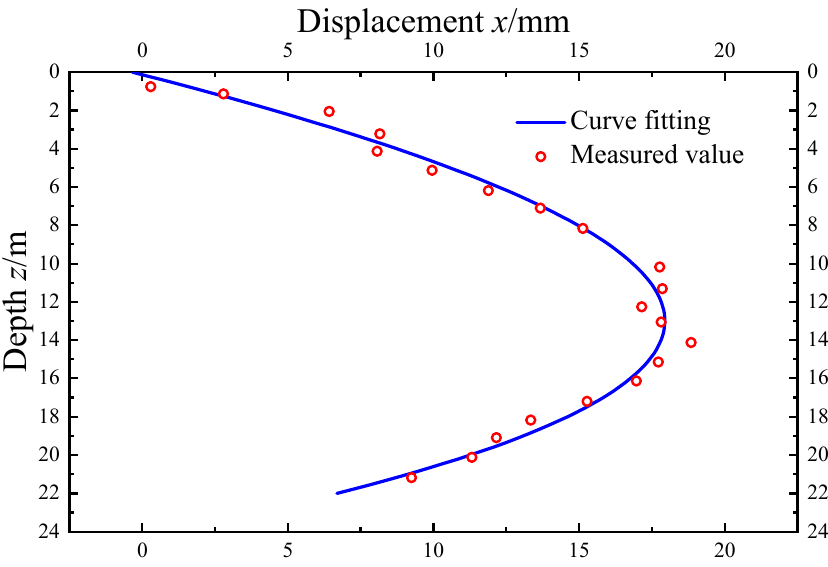
Figure 7. Comparison of the actual measurement and fitting curve of the envelope structure defor- mation.